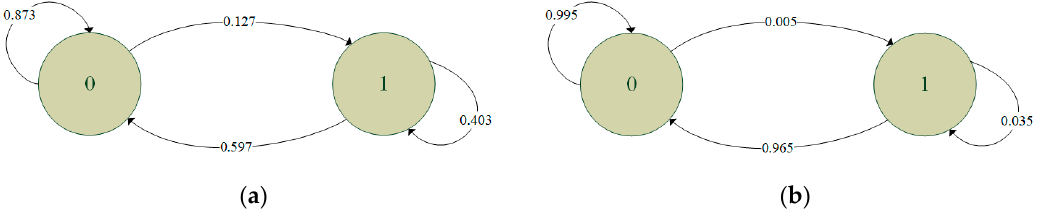
Figure 9. Training results for the two-state Markov model using: ( a ) records in the first minute of the sixth hour, and ( b ) records in the first minute of the tenth hour.